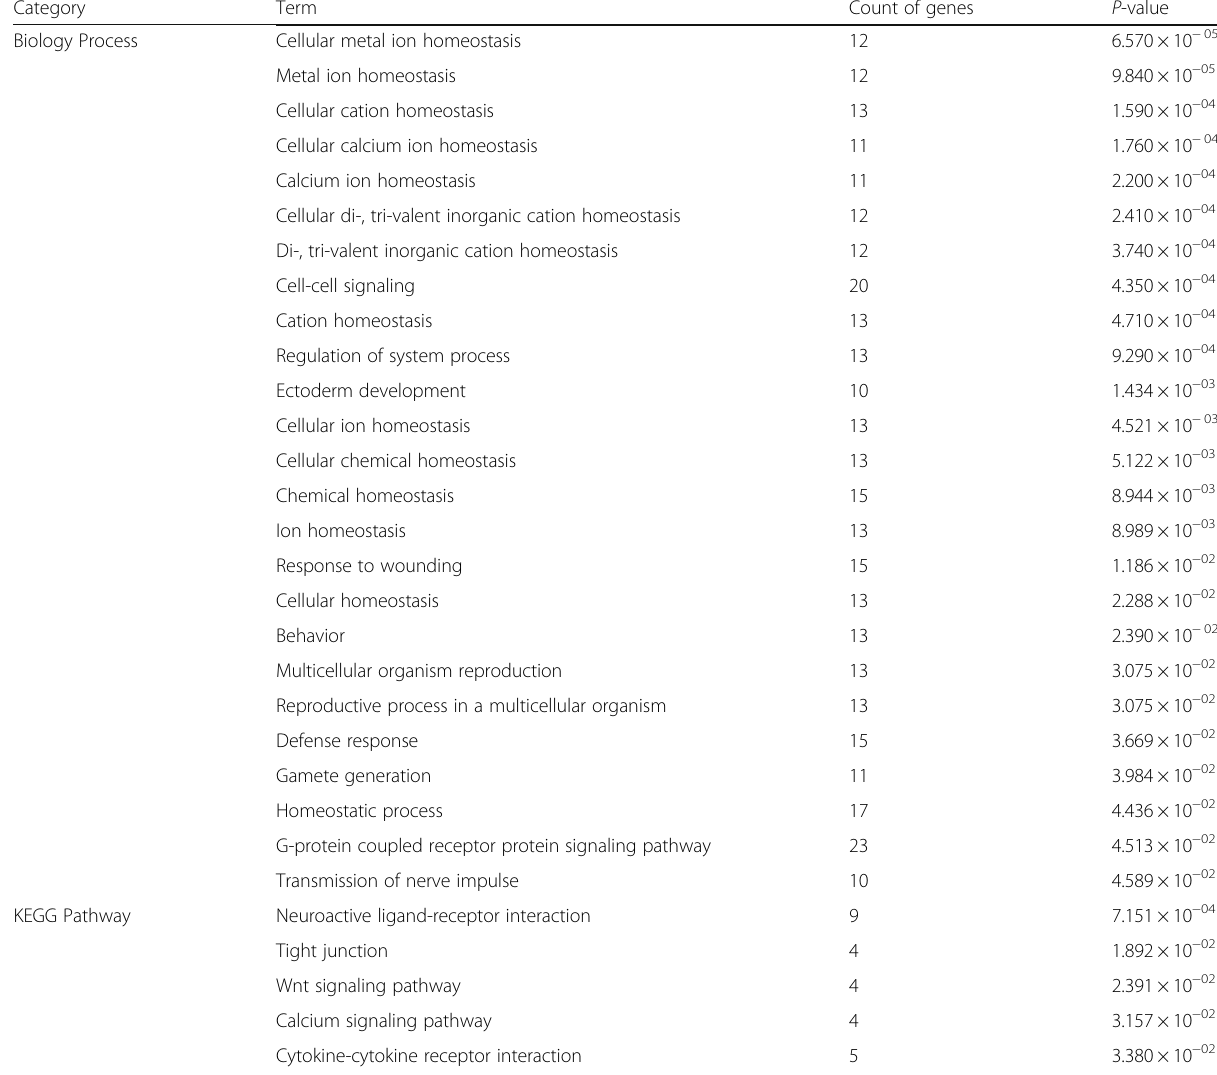
Table 4 Significant GO biological processes and KEGG pathways